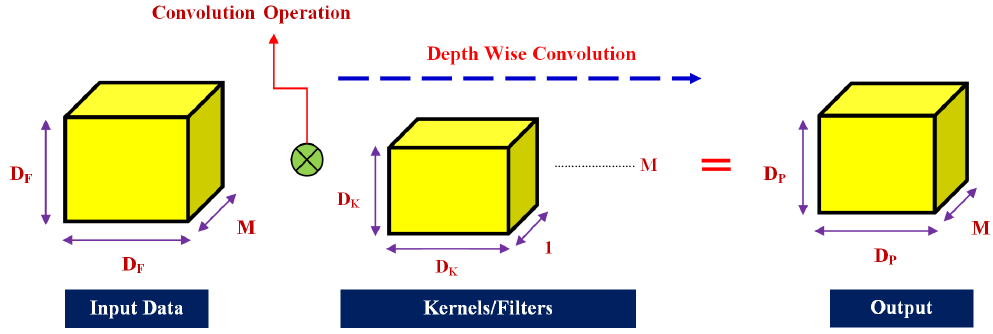
Figure 3. Depthwise